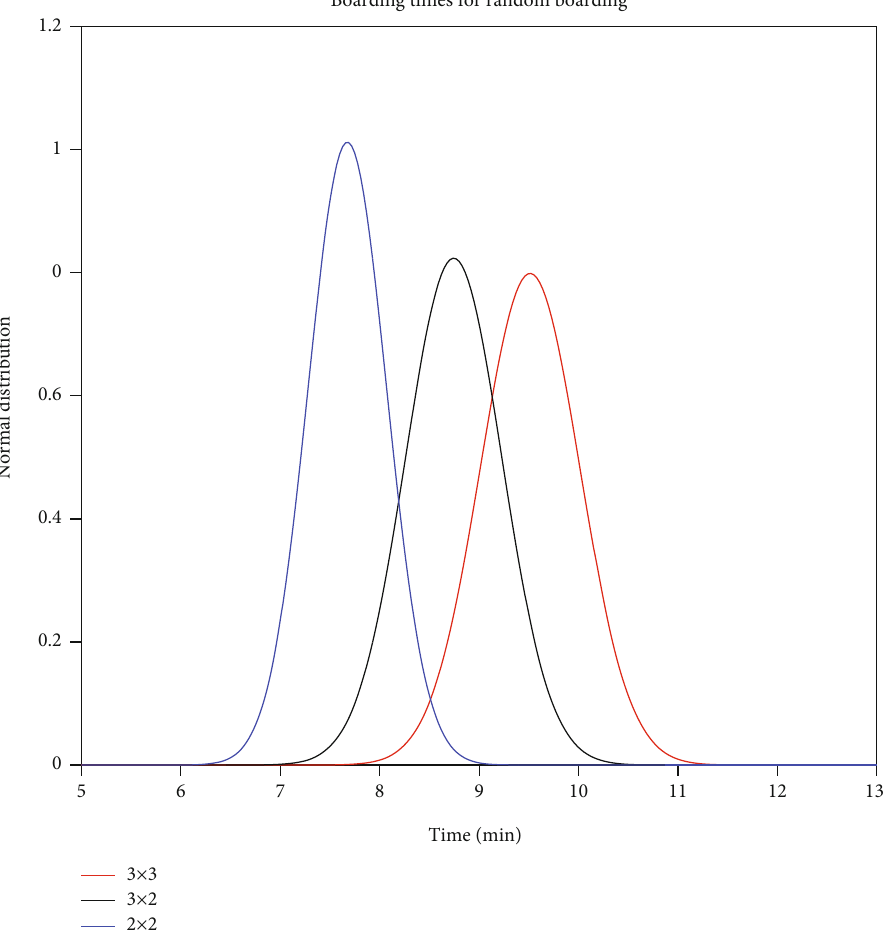
Figure 2: Fitted normal distribution curves for the three aircraft con fi gurations using the random boarding